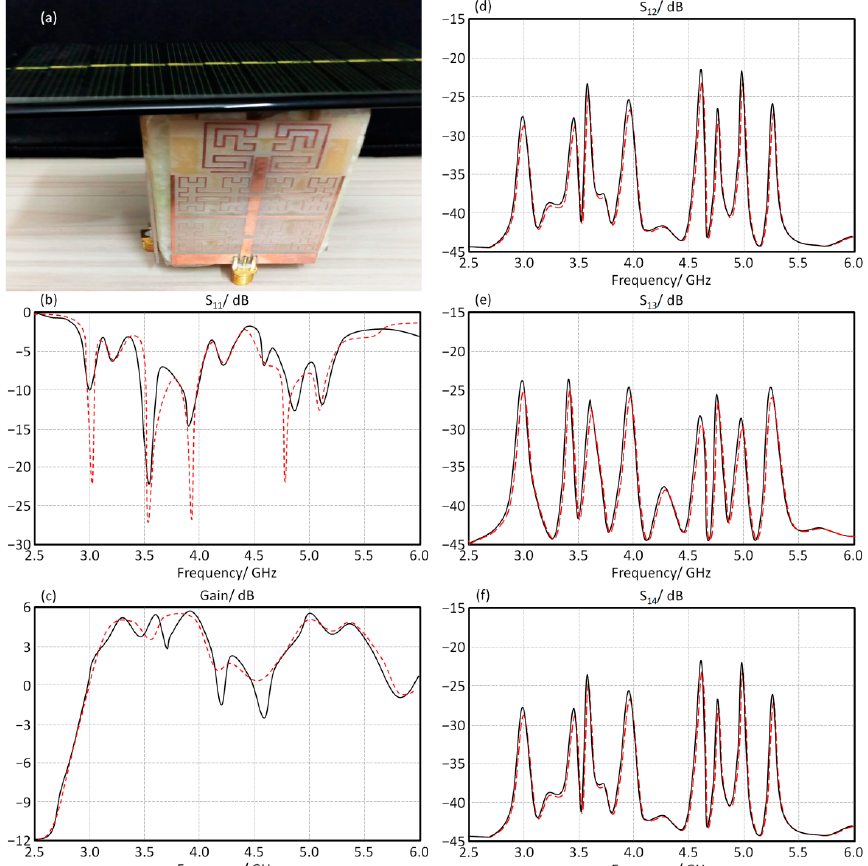
Figure 11. Antenna performance with solar panel introduction; ( a ) antenna design, ( b ) S 11 , ( c ) gain, ( d ) S 12 , ( e ) S 13 , and ( f ) S 14 spectra. Note: The solid black line is for simulation results and the red dotted line for the measured results.